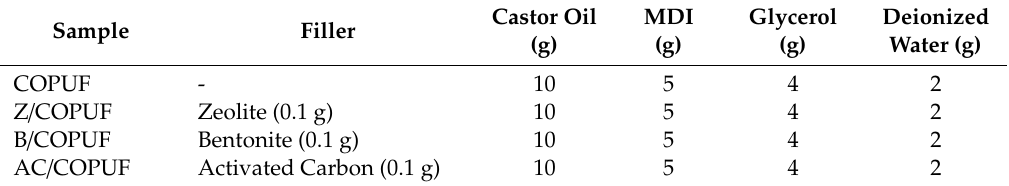
Table 1. Composition variations of castor oil-based polyurethane foams (COPUFs). Sample